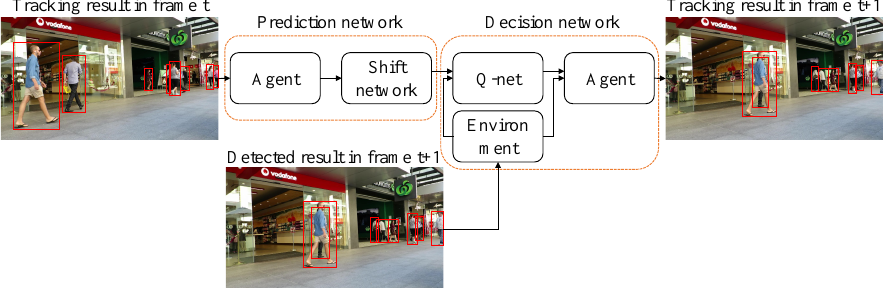
Figure 10. The proposed detection and prediction system [51] in MOT15 benchmark